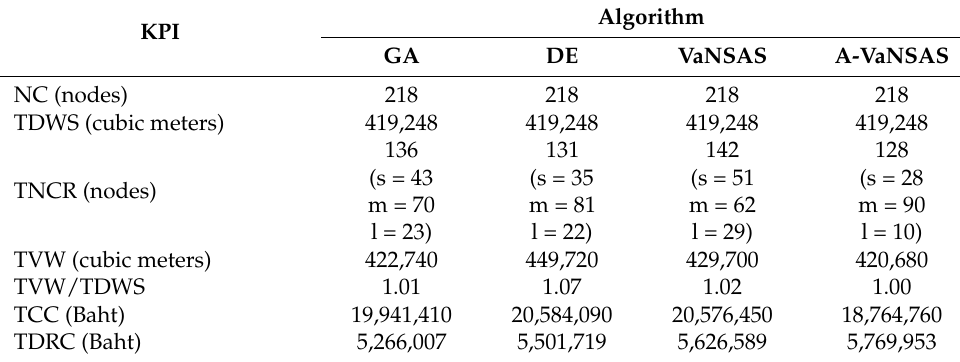
Table 4. Computational results of the case